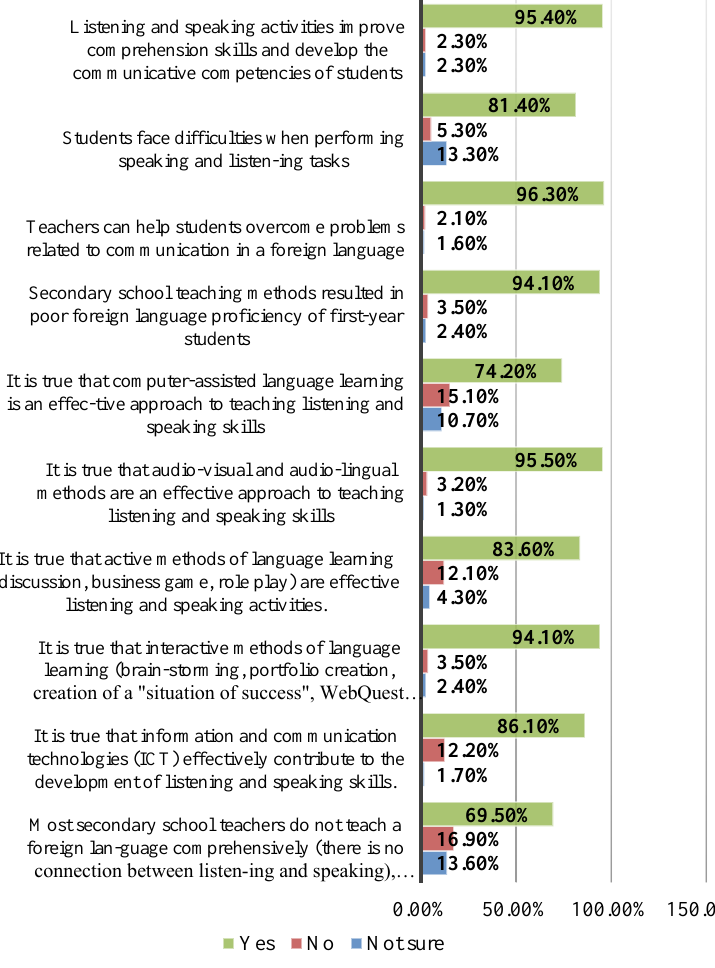
Fig. 2. Diagram of the analysis of the questionnaire of the teachers of the Far Eastern Federal